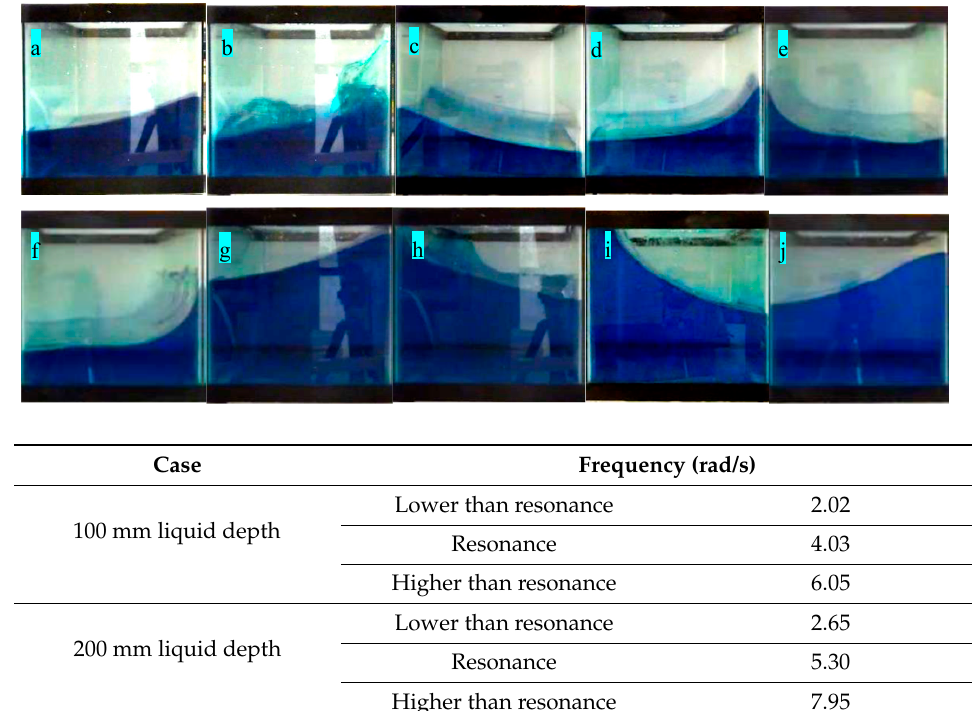
Figure 6. Higher liquid heights observed near the corners of the tank regardless of tank orientation and excitation type.